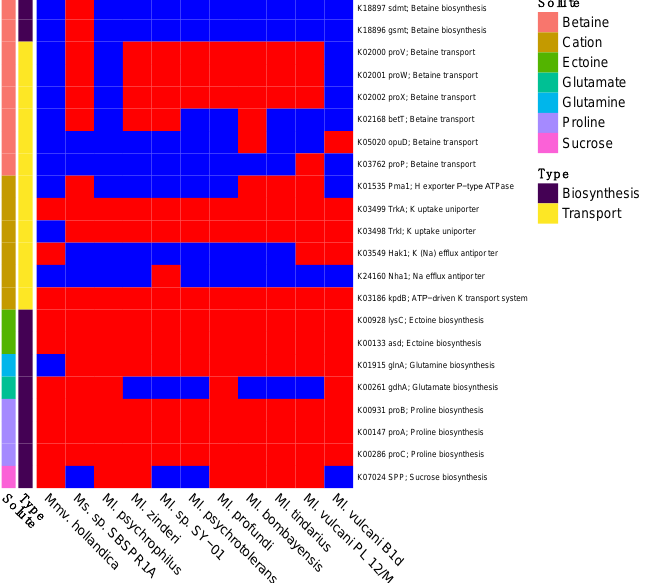
Figure 5. Presence (red) or absence (blue) of genes involved in compatible solute or salt biosynthesis and transport, for salt tolerance. Compounds include betaine, cations (K + or Na + ), ectoine, glutamate, glutamine, proline, and sucrose. The gene names and their KEGG K number assignments are shown. Columns were clustered according to the phylogeny in Figure 1.